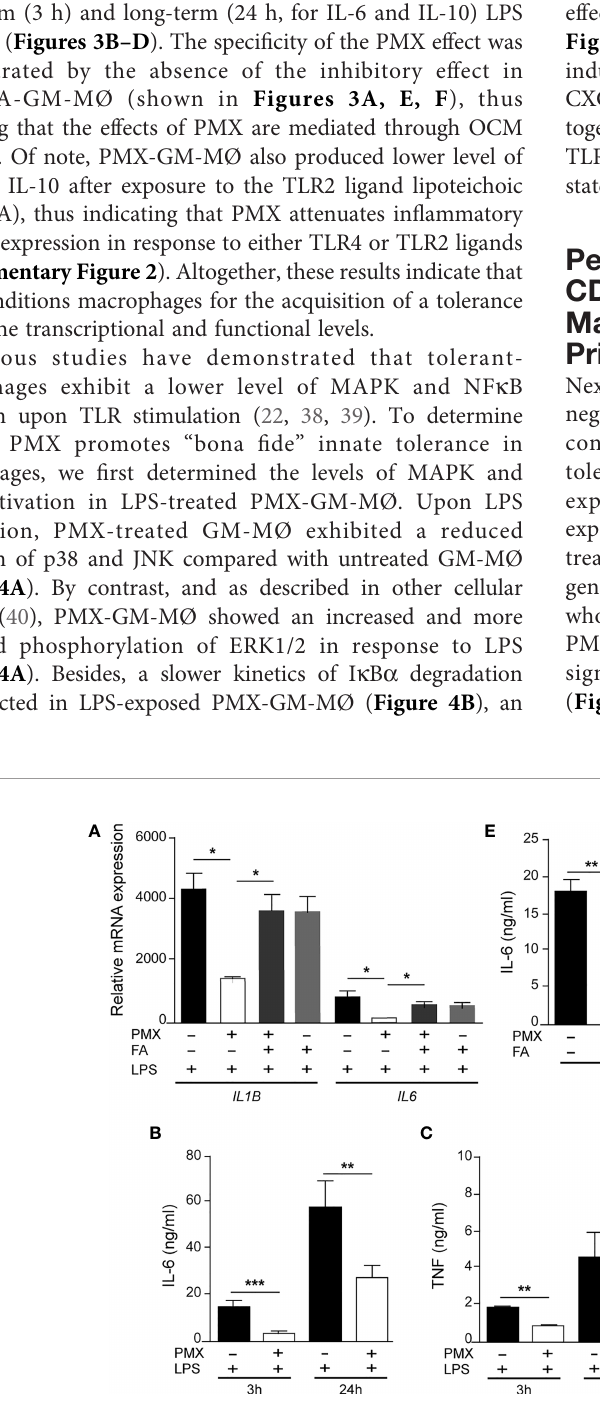
FIGURE 3 | PMX alters TLR4 responsiveness in GM-CSF-primed macrophages. (A) Expression of IL1B and IL6 by monocytes differentiated with GM-CSF in the absence or presence of PMX (50 nM), folinic acid (FA; 5 µM), or both and challenged with LPS for 3 h, as determined by qRT-PCR. Mean ± SEM of three independent donors are shown. Groups were compared by applying one-way ANOVA (* p < 0.05). Production of IL-6 (B) , TNF a (C) , or IL-10 (D) by monocytes differentiated with GM-CSF in the absence or presence of PMX and challenged with LPS for 3 and 24 h, as determined by ELISA. Mean ± SEM of seven independent donors are shown (* p < 0.05, ** p < 0.01, *** p < 0.001). Production of IL-6 (E) and TNF a (F) by monocytes differentiated with GM-CSF in the absence or presence of PMX (50 nM), folinic acid (FA; 5 µM), or both and challenged with LPS for 3 h, as determined by ELISA. Mean ± SEM of fi ve independent donors are shown. Groups were compared by applying one-way ANOVA (with Tukey ’ s post-hoc test, * p < 0.05, ** p < 0.01). PMX, pemetrexed; GM-CSF, granulocyte- macrophage colony-stimulating factor; LPS,